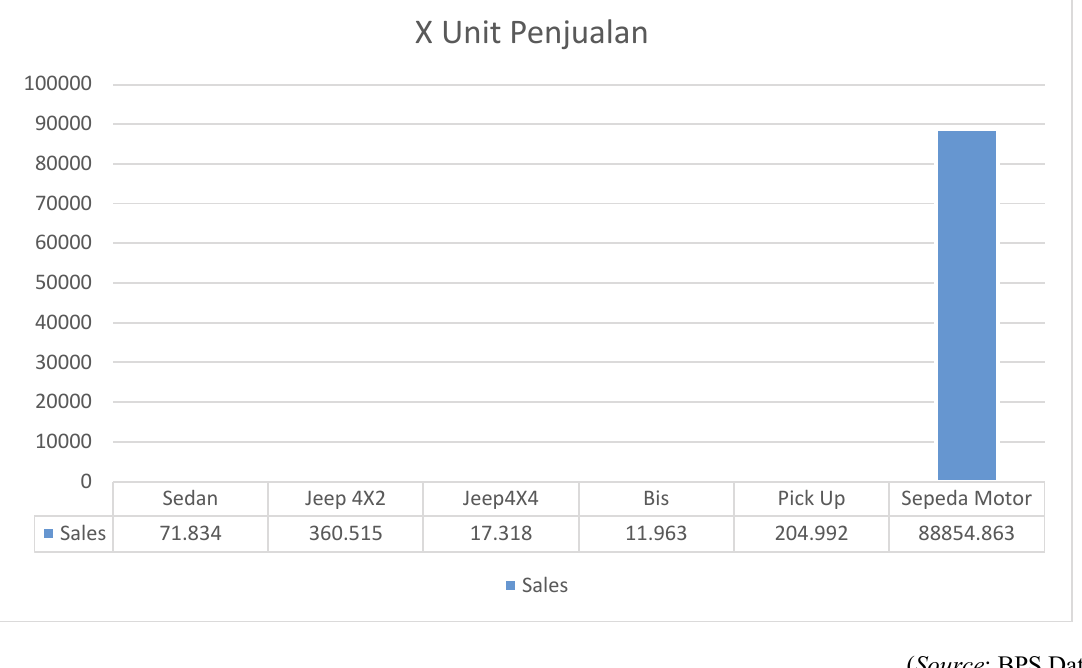
Fig. 1 . Average Domestic Vehicle Production in Indonesia